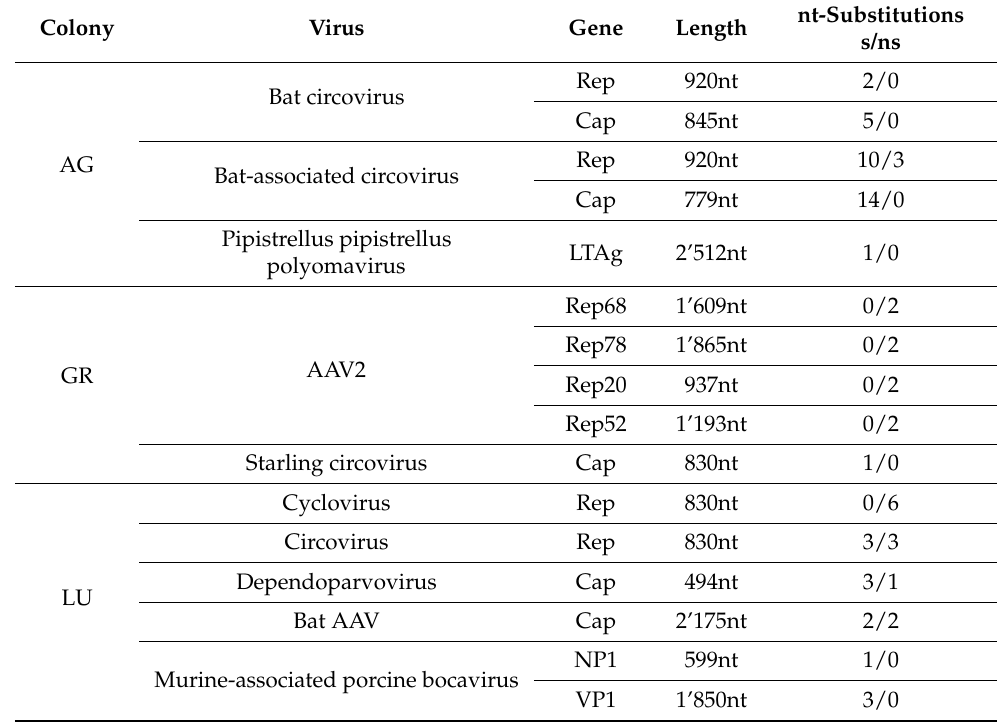
Table 1. SNVs detected in selected DNA viruses found in the bat colonies. Genes are shown with the length and number of synonymous (s)/non-synonymous (ns) nucleotide (nt) substitutions. Colony